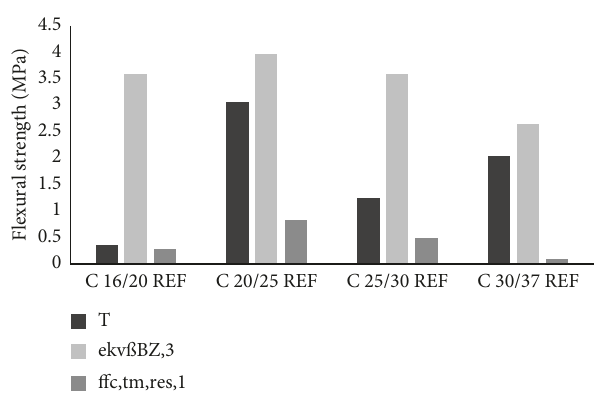
Figure 6: Residual tensile strength in bending at the moment of achieving a deflection of 3.5mm, reference mixture of common concrete.